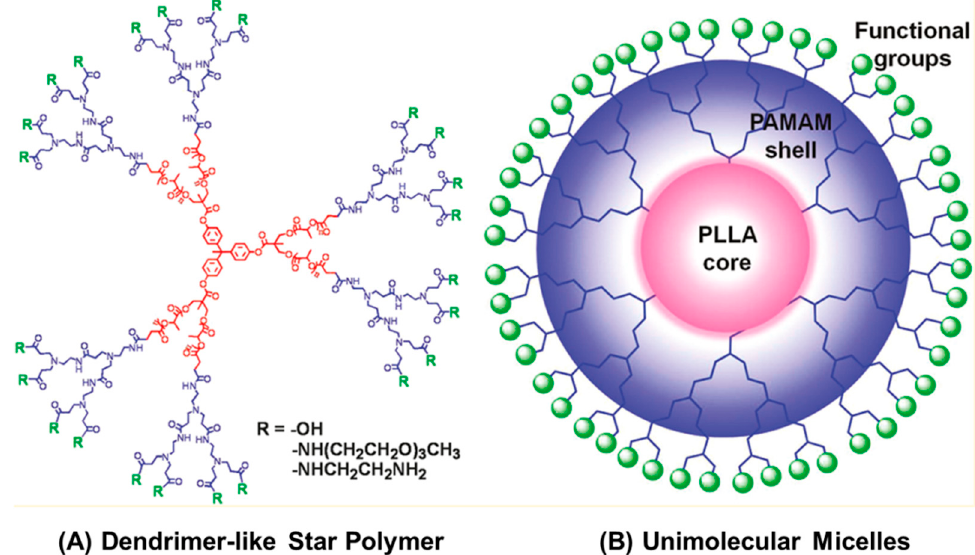
Figure 21. ( A ) Structure of the hydrophobic dendrimer-like star core polymer derived from poly( L -lactide) (PLLA); ( B ) a unimolecular core–shell micelle structure derived from a hydrophobic poly( L -lactide) (PLLA) core and a shell composed of poly(amidoamine) (PAMAM) dendrons. with permission from [76]. Copyright 2011 American Chemical Society. Reprinted with permission from [76]. Copyright 2011 American Chemical Society.